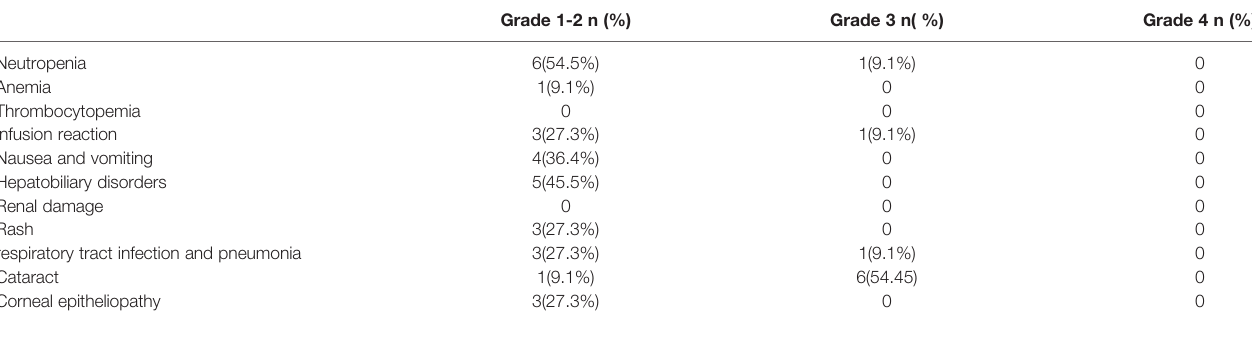
TABLE 3 | Systemic and local adverse events during treatment.